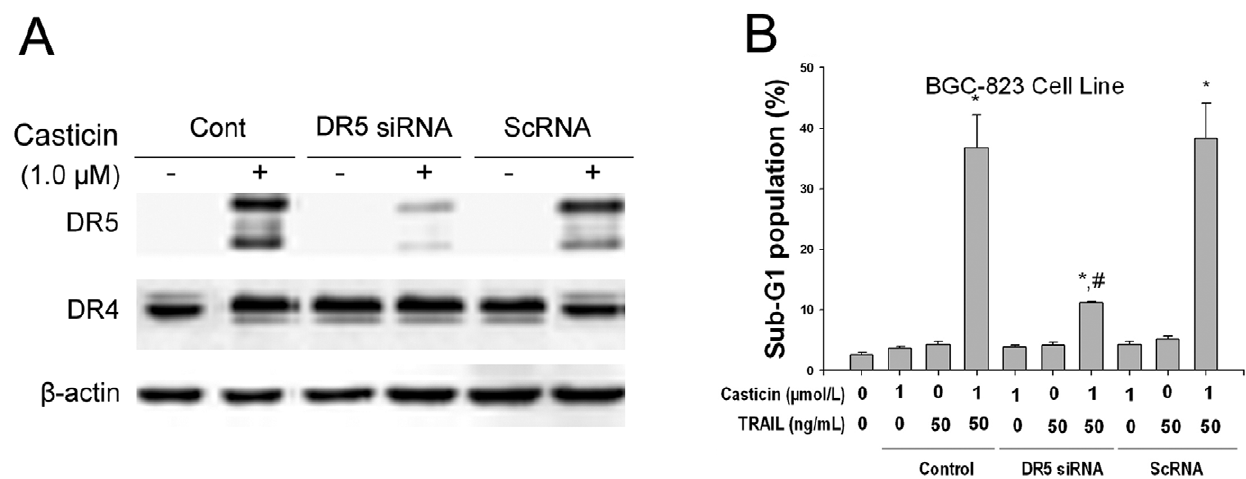
Figure 4. Knockout of DR5 by siRNA attenuated the effect of co-treatment of casticin and TRAIL on apoptotic cell death of BGC-823 cells. Action of siRNA for DR5, on the effects of casticin-induced DR5 expression levels (A) using western blot analysis and TRAIL-mediated apoptosis (B). * P , 0.05 vs. treatment with DMSO; # P , 0.05 vs. treatment with 1 m mol/l casticin plus 50 ng/ml TRAIL in control and scRNA transfected cells.